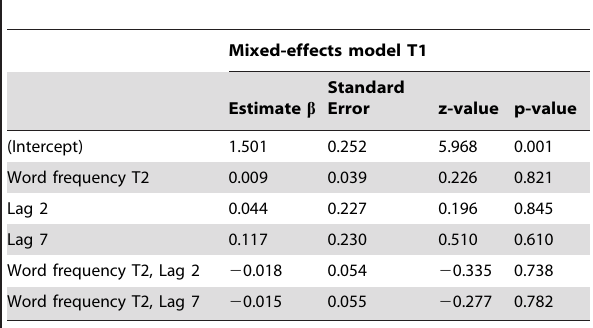
Table 3. The estimates and z-values of the mixed-effects model for T1 accuracy.